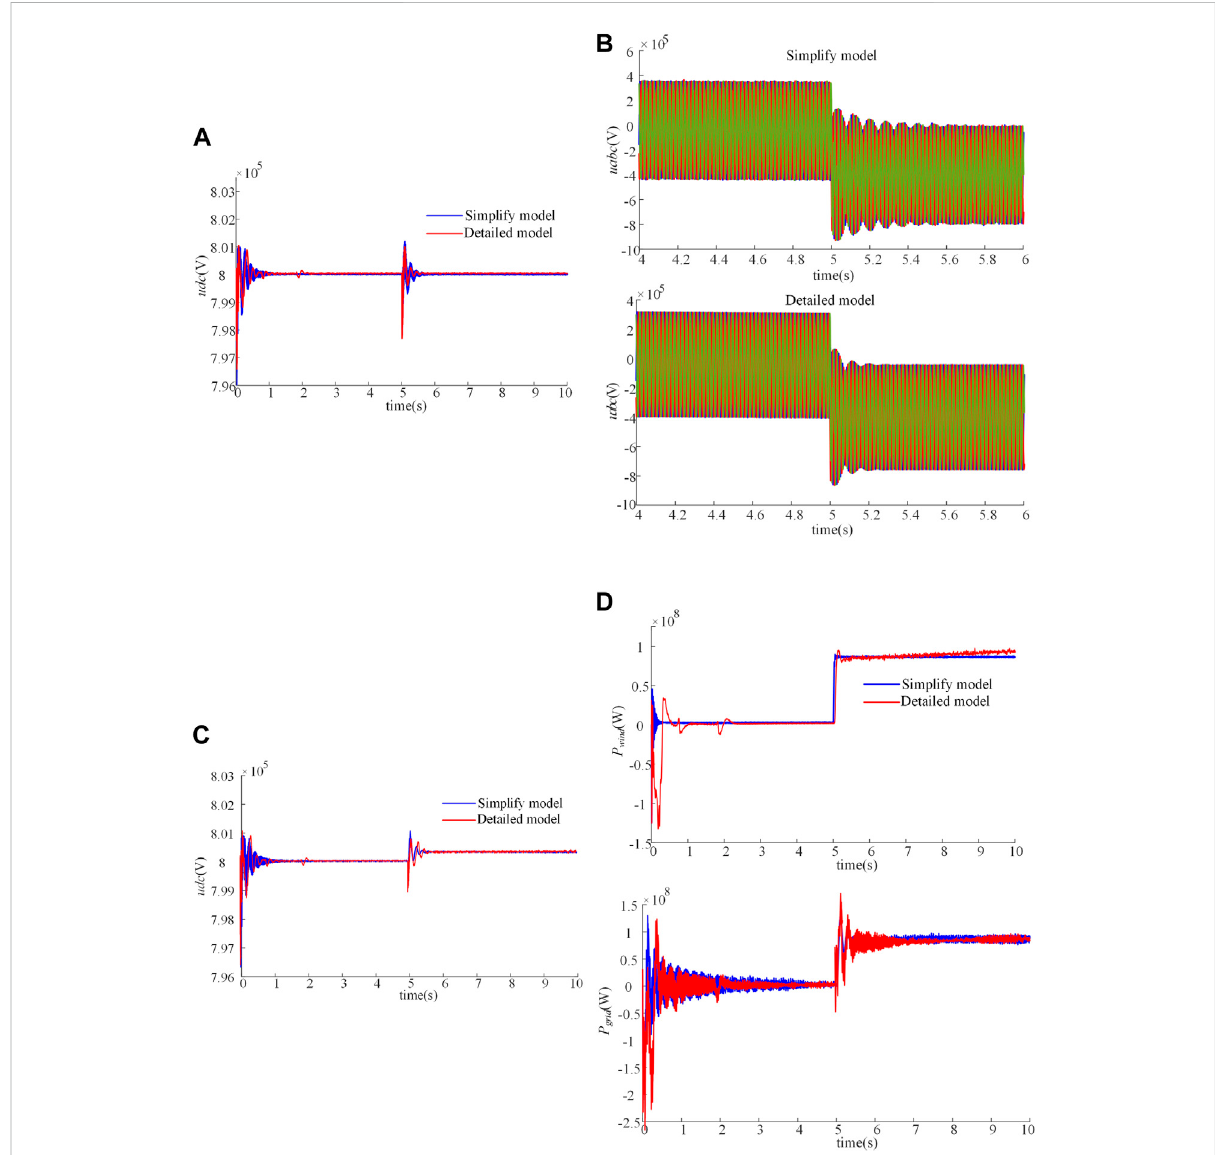
FIGURE 10 Supplementary fault analysis of wind farm grid connection. (A) (B) Waveform of DC-side voltage and wind farm-side voltage during a single- pole DC ground fault (C,D) show the waveforms of DC voltage, wind farm output power, and grid-connected power under the step change of wind speed.Theaforementionedsectionconsidersthethree-phasevoltagecomparisonandwindspeedvariationofthewindfarmasasupplementtothe simulation analysis and compares the dynamic characteristics of the simpli fi ed equivalent model with the detailed model under various operating conditions to further verify the effectiveness of the simpli fi ed equivalent strategy in this